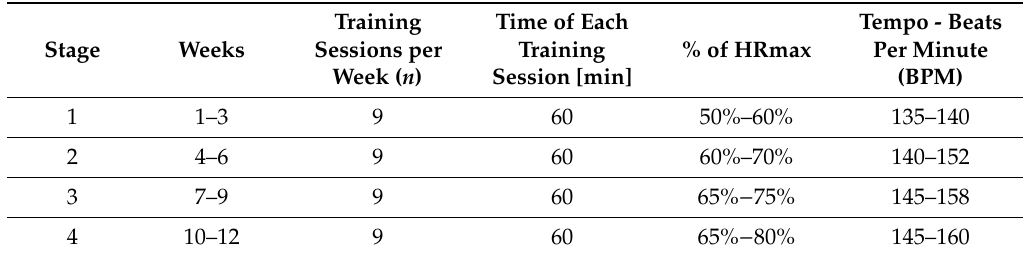
Table 1. Experimental training program of low and high impact aerobics